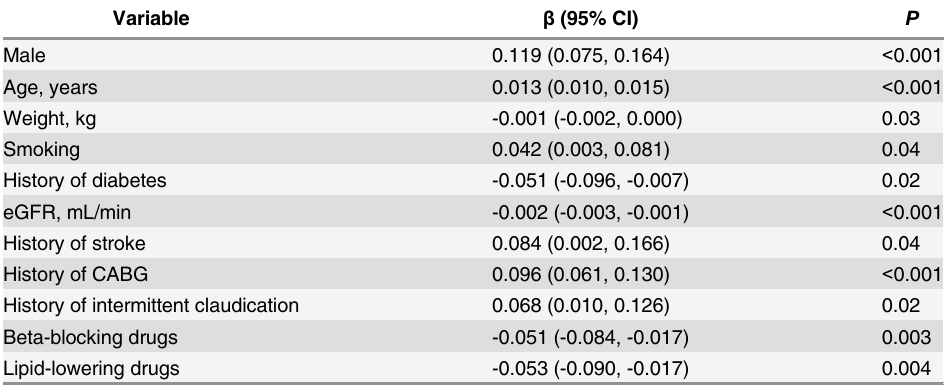
Table 2. Variables Associated with Ln